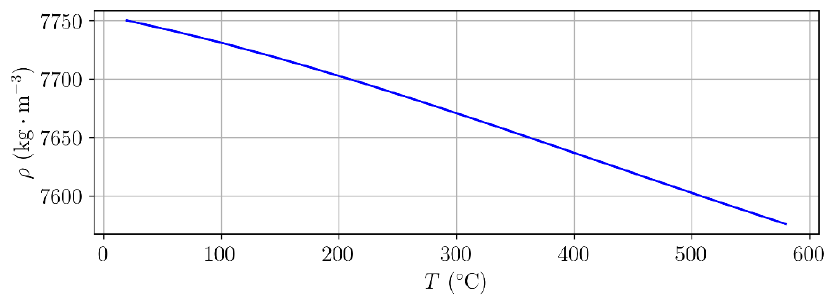
Figure 4. Temperature dependence of specific mass (powder H13).